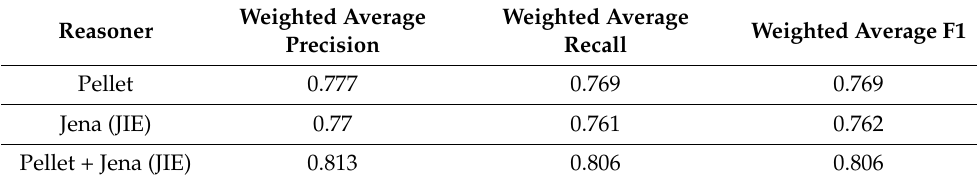
Figure 13. Predicted roles evaluation (average precision, recall and F1). Table 4. Predicted roles evaluation (weighted average values for precision, recall and F1).